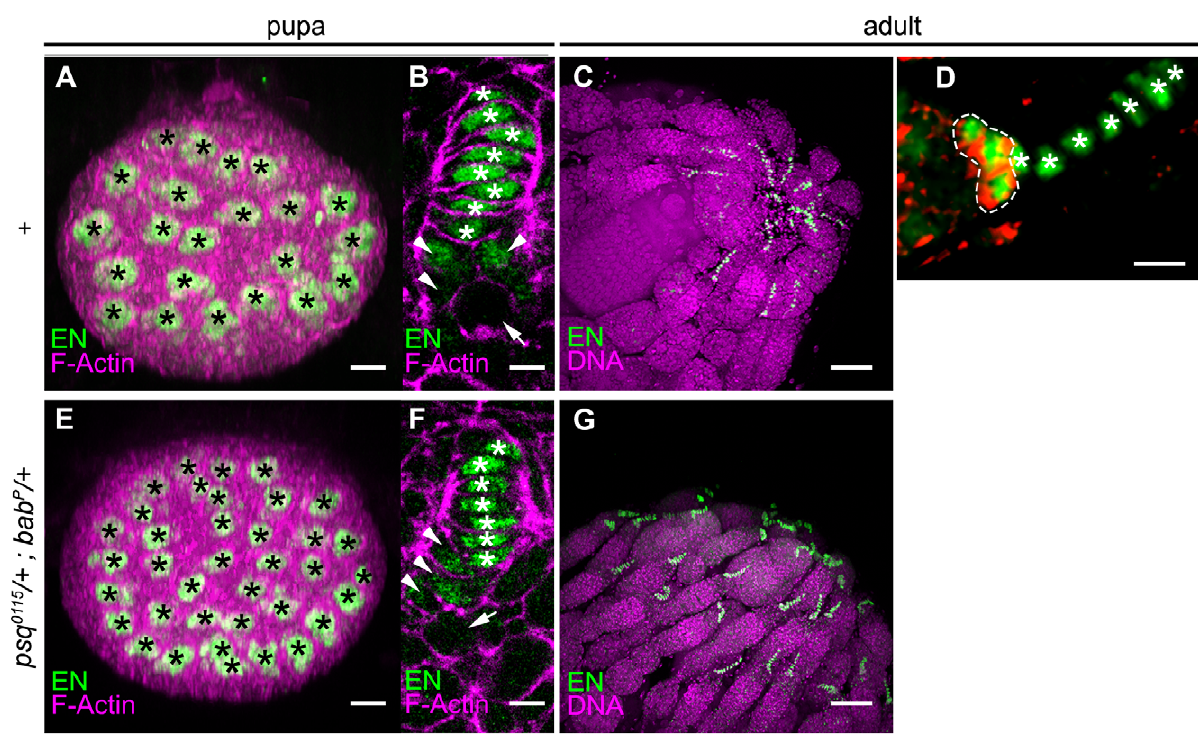
Figure 4. Detection of TFCs in the pupal and in the adult ovary. (A–D) Wild type control (Canton-S). (E–G) psq 0115/ + ; bab P/ + heterozygotes. EN positive (green) cells include two cell populations, TFCs (white stars in B, D, F), and CC (arrowheads in B, F, circled by a dotted white line in D). At the early pupal stage (A, B, E, F), confocal projections through the anterior/posterior axis of ovaries (A, E) allows counting of the number of TF per ovary (each TF is marked by a black star). Sections through individual early pupal TFs (B, F) allow discrimination between TFCs with a flattened nucleus (white stars) and CCs with a more rounded nucleus (arrowheads in B, F) located posterior to TFCs. Germ cells are marked by an arrow. In one-day-old flies (C, D, G), counting of TFs and TFCs was performed on confocal 3D stacks from whole mount ovaries stained with anti-En (green), anti DE- Cadherin (red, in D) and TO-PRO-3 H (purple, in D, G). TFs protrude at the tip of the germarium. In the germarium, CCs (circled by a dotted white line) accumulate high levels of DE-cadherin (red), whereas the adjacent basal TFCs do not. Anterior to the right. Scale bar : (A, E) 10 m m, (B,F) 2.5 m m, (C, G) 40 m m, (D) 5 m m.